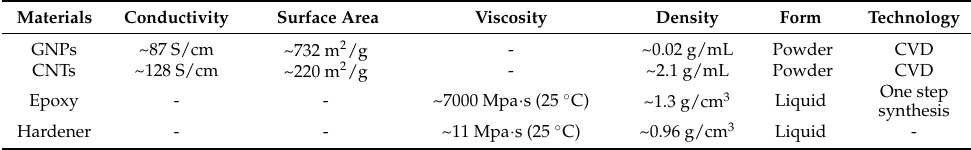
Table 1. Physicochemical properties and production technology of raw